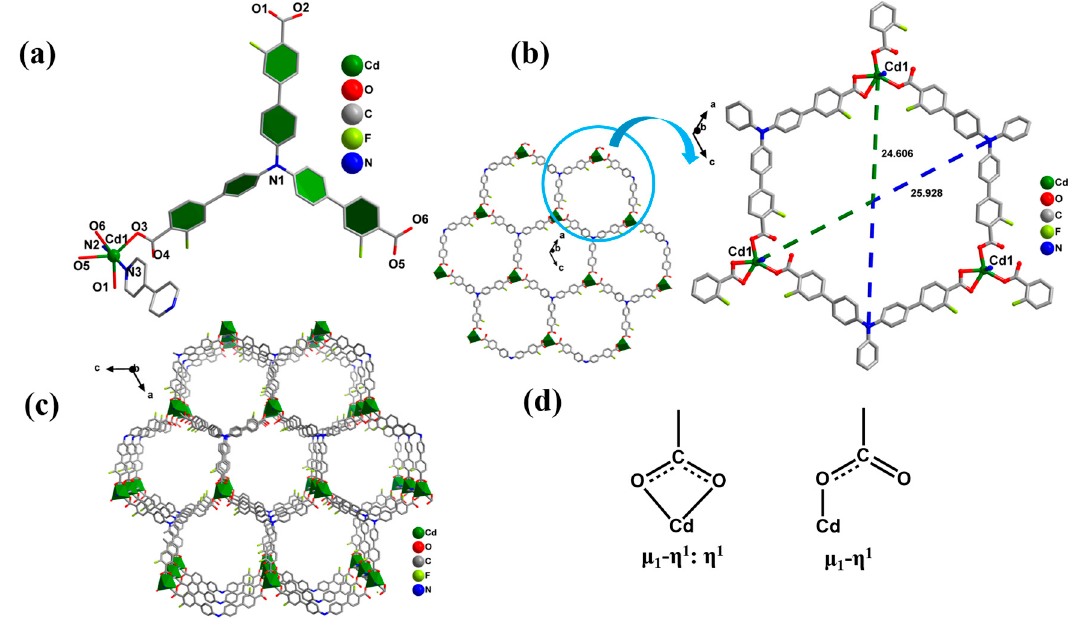
Figure 2. ( a ). The asymmetric of CdMOF-2 . ( b ). 2D layers of CdMOF-2 . Enlarged part: A hexagon pore with 66-members ring with pore size of 24.6 × 25.9 Å. ( c ). Single 3D network of CdMOF-2 . ( d ) Coordination modes of TFBA 3 − to Cd(II) center.